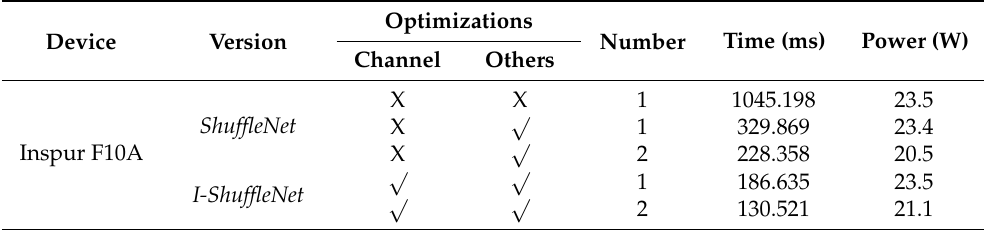
Table 3. Experimental